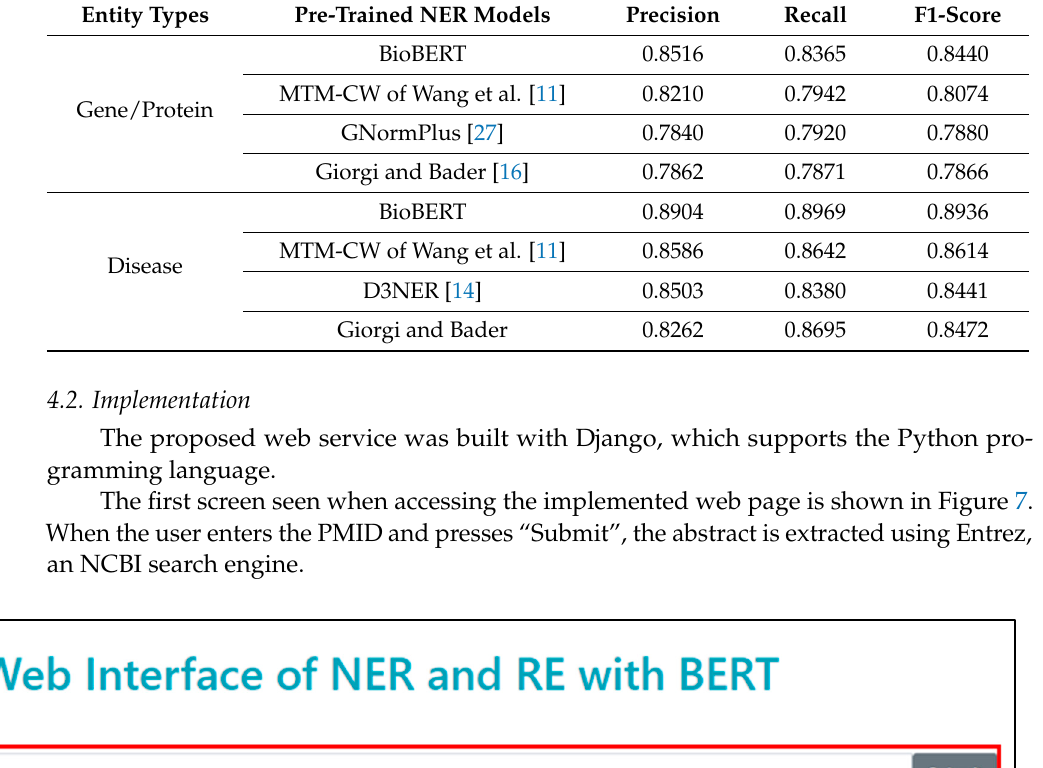
Table 5. Performance comparison of models for entity types (genes/proteins, diseases).